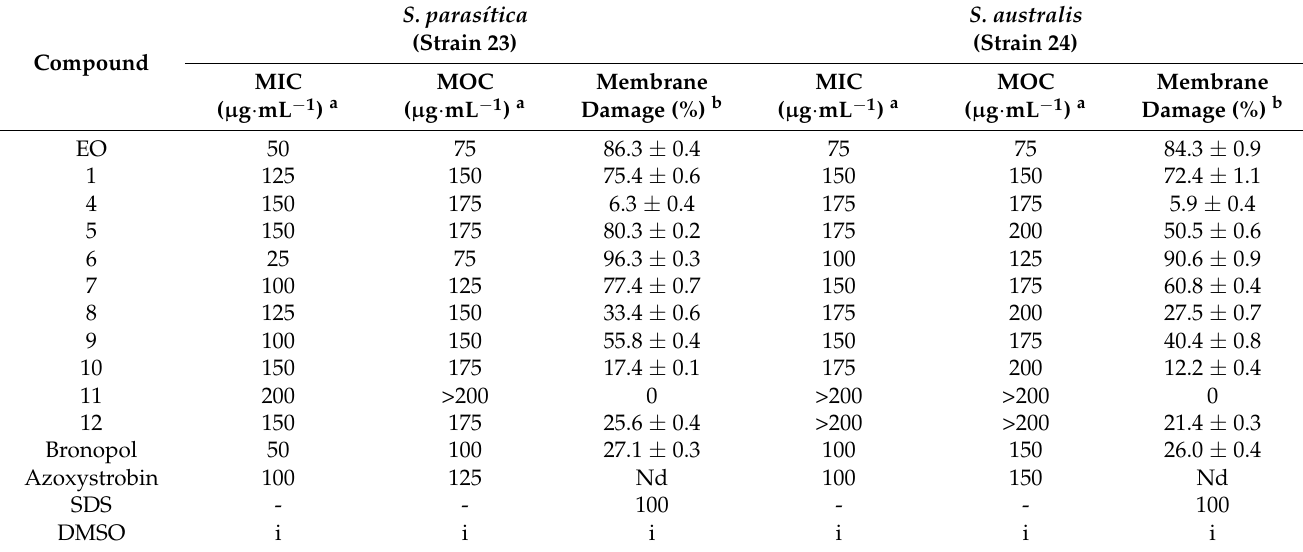
a Each value represents the mean of three experiments. b Each value represents the mean ± SD of three experiments, performed in quadruplicate. Nd: not detected; i: